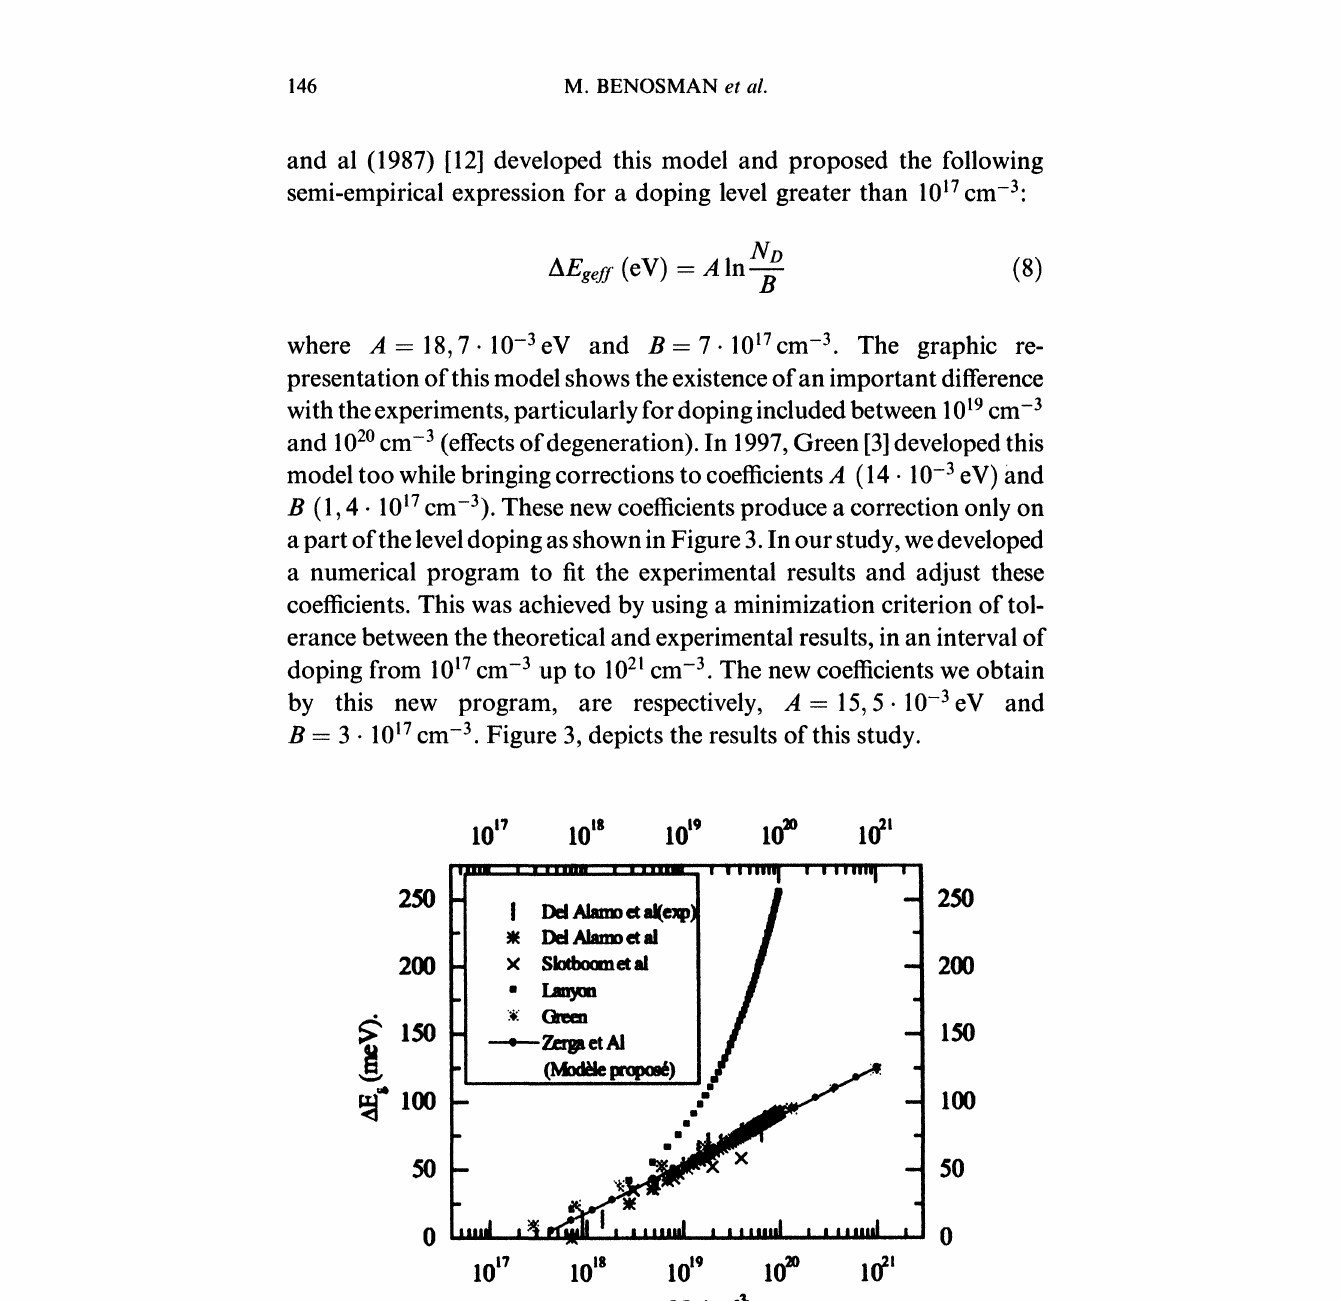
FIGURE 3 The band-gap narrowing AEg according to the donor’s concentration